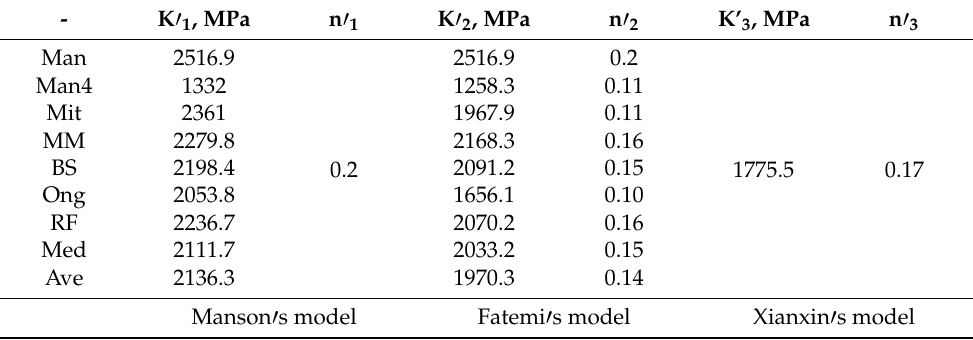
Table 4. Material cyclic hardening models estimated for EI-961